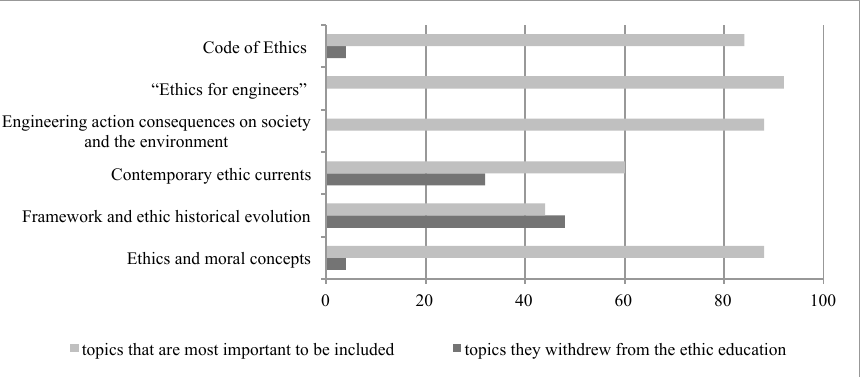
Fig. 4. students answers (% of total students): "From the topics covered in the training, which would you remove and which ones would do you consider most important?"